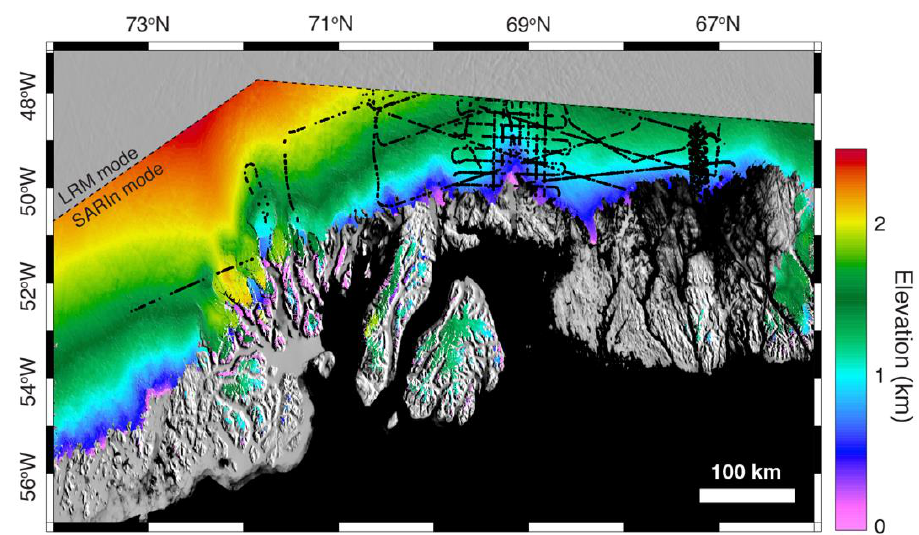
Figure 9. Location of the collocated swath-OIB (Operation Ice Bridge) measurements. EOLIS (Elevation Over Land Ice from Swath) DEM along the west coast of the Greenland Ice Sheet overlaid over the MEaSUREs MODIS (Moderate Resolution Imaging Spectroradiometer) Mosaic of Greenland [23]. The inland limit of the DEM corresponds to the CryoSat-2′s SARIn mode mask (dashed line); elsewhere the ice mask is in accordance with the Greenland Ice Mapping Project (GIMP) dataset [24]. Ice Bridge elevation acquired in March, April and May 2011 (black). Figure taken from [12].